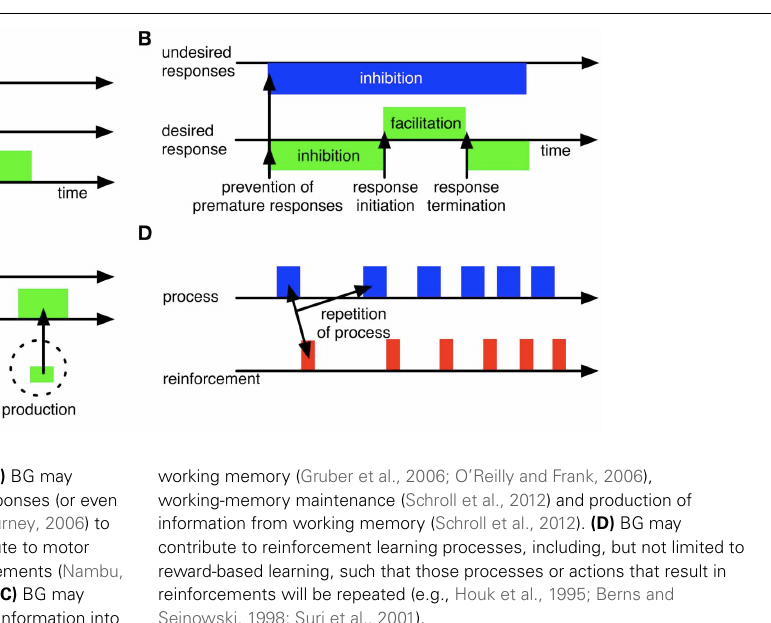
working memory (Gruber et al., 2006; O’Reilly and Frank, 2006), working-memory maintenance (Schroll et al., 2012) and production of information from working memory (Schroll et al., 2012). (D) BG may contribute to reinforcement learning processes, including, but not limited to reward-based learning, such that those processes or actions that result in reinforcements will be repeated (e.g., Houk et al., 1995; Berns